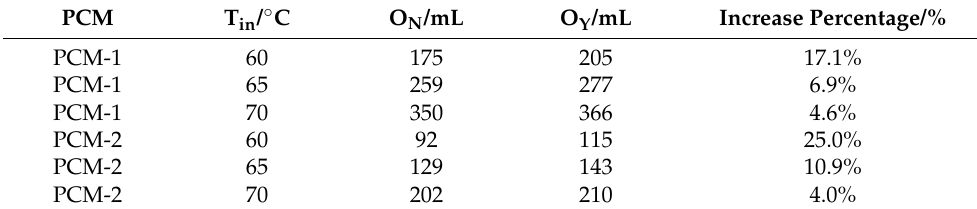
Table 5. Water output before and after adding copper wire